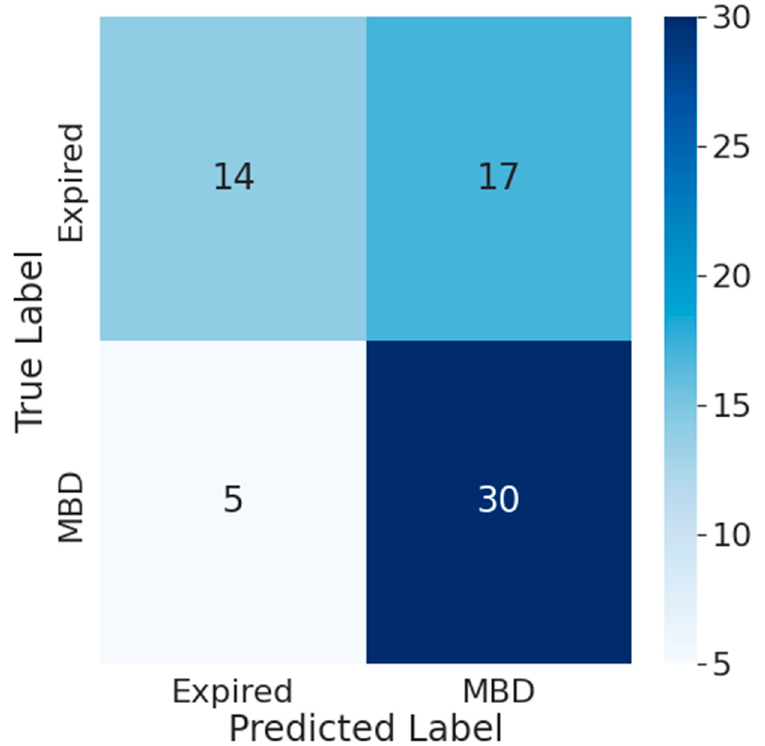
Figure A12. BiLSTM model confusion matrix using the clinical and wearable data.